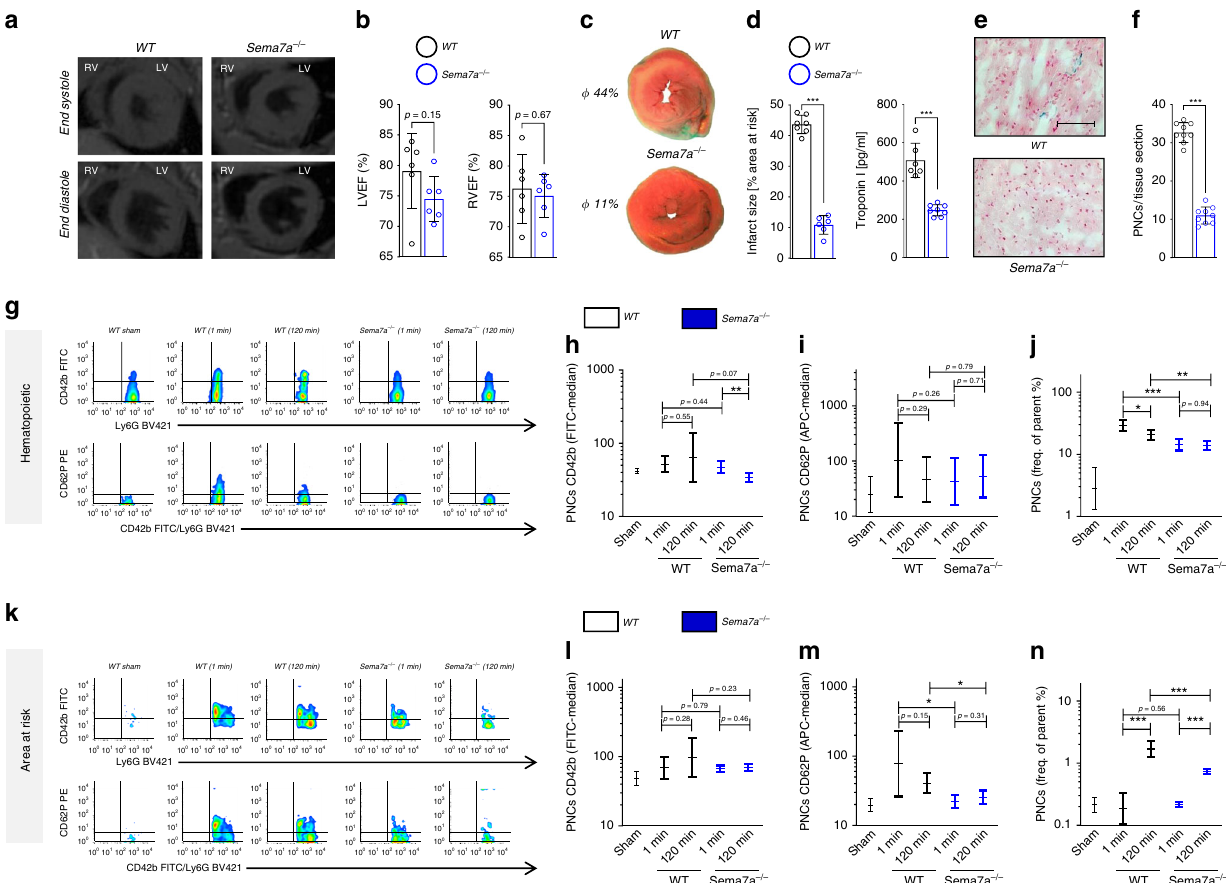
Fig. 3 Sema7a − / − animals show reduced signs of MIRI and attenuated PNC formation. a Sema7a − / − animals and littermate controls were evaluated by magnetic resonance tomography (MRT) to exclude anatomical and functional alterations in Sema7a − / − animals ( n = 6/group). b Left and right ventricular ejection fraction (LVEF or RVEF in %) determined through MRT ( n = 6/group). c Sema7a − / − mice and littermate controls were exposed to 60 min of ischemia and 120 min of reperfusion with samples taken after 1 or 120 min of reperfusion. Representative TTC-stained slices of myocardial tissue showing infarcted area (blue/dark = retrograde Evans blue staining; red and white = AAR, white = infarcted tissue, 120 min) with d systematic evaluation of infarct sizes ( n = 7;6) and corresponding troponin I plasma levels ( n = 6;8). e Representative histological sections (scale bar 100 µ m) of Sema7a − / − and littermate control hearts (120 min). f Number of PNCs in myocardial tissue sections in AAR of Sema7a − / − mice and littermate controls (120 min, n = 9/group). g Representative fl ow-cytometric plots of PNCs in the blood of Sema7a − / − and littermate controls, showing GPIb (CD42b) and P-selectin (CD62P) after 1 and 120 min reperfusion. Mean fl uorescence intensity (MFI) for h GPIb (CD42b, n = 6;7;7;7;7) and i P-selectin (CD62P, n = 7/group) in PNCs and j systematic evaluation of PNCs in % by fl ow cytometry in the blood of Sema7a − / − animals and littermate controls ( n = 7/group). k Representative fl ow-cytometric plots of PNCs in the AAR and MFI for l GPIb (CD42b, n = 7;7;7;7;6) and m P-selectin (CD62P, n = 7;6;7;7;7) and n systematic evaluation of PNCs by fl ow cytometry in % in the AAR of WTs and Sema7a − / − animals at 1 min and 120 min ( n = 6;7;7;7;7). Comparisons in b , d , f were analyzed by unpaired two-tailed Student ’ s t -tests (data are mean ± SD). For h – j , l – n we used log transformation of data to conform normality. For log-transformed data, unpaired two-tailed Student ’ s t -tests were performed on the log values and results are displayed as geometric means and their 95% con fi dence intervals. * p < 0.05, ** p < 0.01, and *** p < 0.001 as